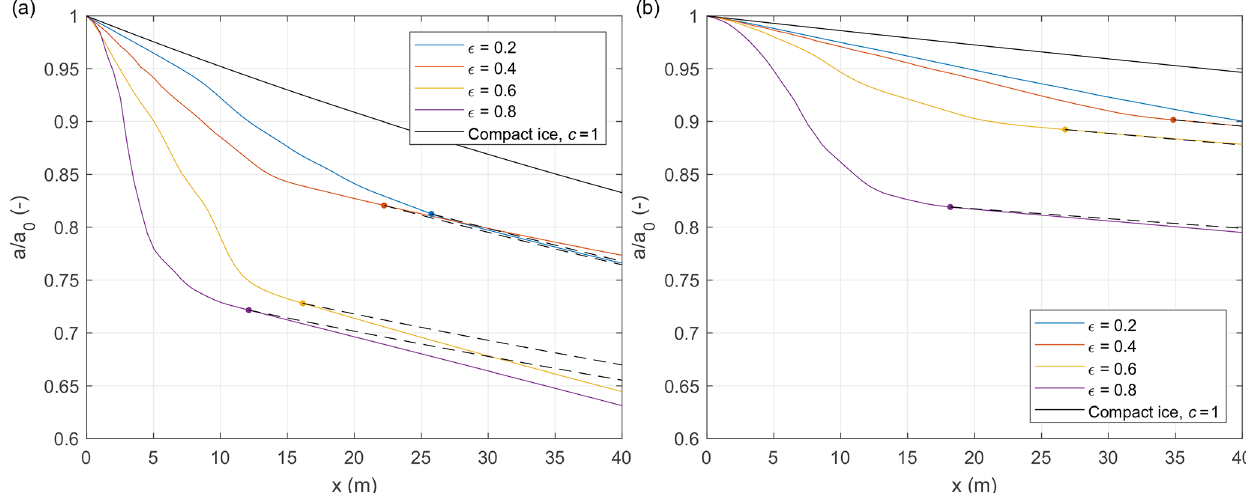
Figure 2. Computed relative wave amplitude a/a 0 for simulations with L x = 0 . 5m, T = 1 . 2s, a 0 = 0 . 0125m, d f = 0 . 005m, and C sd = 0 . 05, with ML (a) and EP (b) dispersion relation. Colours correspond to different restitution coefficients ε ; continuous black line shows the curve computed from Eq. (25), with α c from Eq. (24). Dots mark locations where the phase-averaged floe–floe distance drops below 10 − 4 m (see Fig. 3a), and black dashed lines originating from those points show corresponding solutions for compact